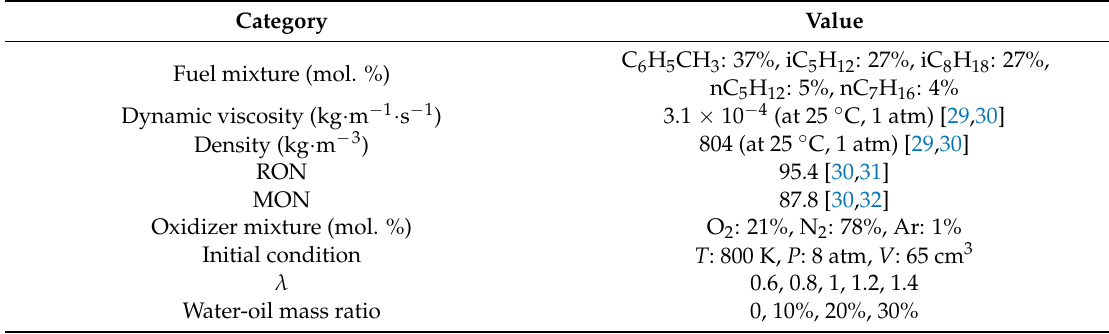
Table 1. Properties of the oil and experimental